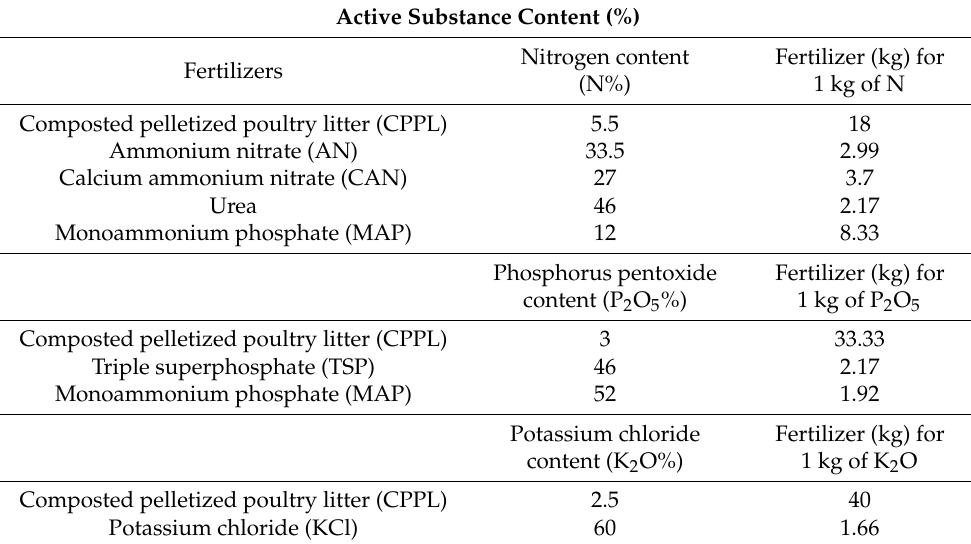
Table 4. Active substance content of fertilizers (N%), (P 2 O 5 %), and K 2 O%) and the amount of fertilizer needed to apply 1 kg of the active substance.